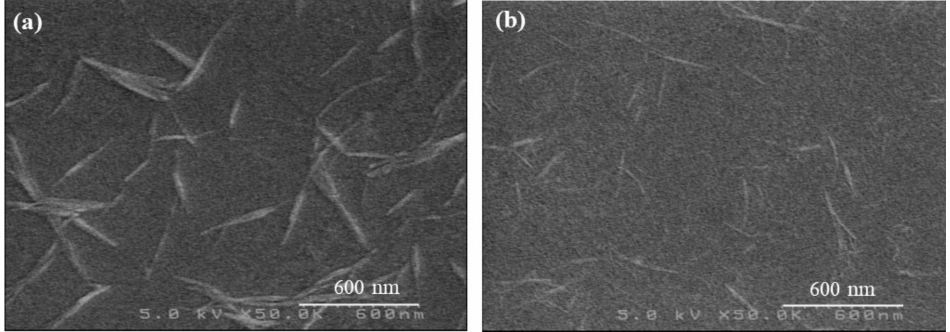
Figure 2. SEM images of the ( a ) parent ChNF/methanol dispersion and ( b ) SD-ChNF/aqueous acetic acid dispersion.